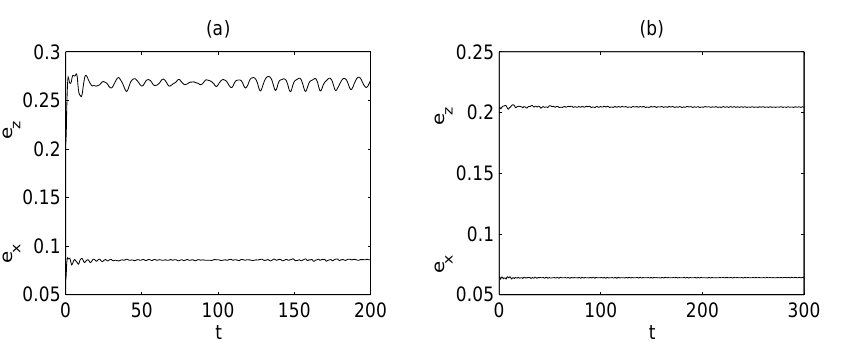
FIG. 10. Emittance growth due to the redistribution process for initially matched beam ( (cid:99) (cid:121) (cid:97) (cid:173) (cid:51)(cid:44) h (cid:120) (cid:173) (cid:48)(cid:46)(cid:51)(cid:56)(cid:44) h (cid:122) (cid:173) (cid:48)(cid:46)(cid:50)(cid:55) ): (a) Gaussian distribution and (b) uniform distribution.